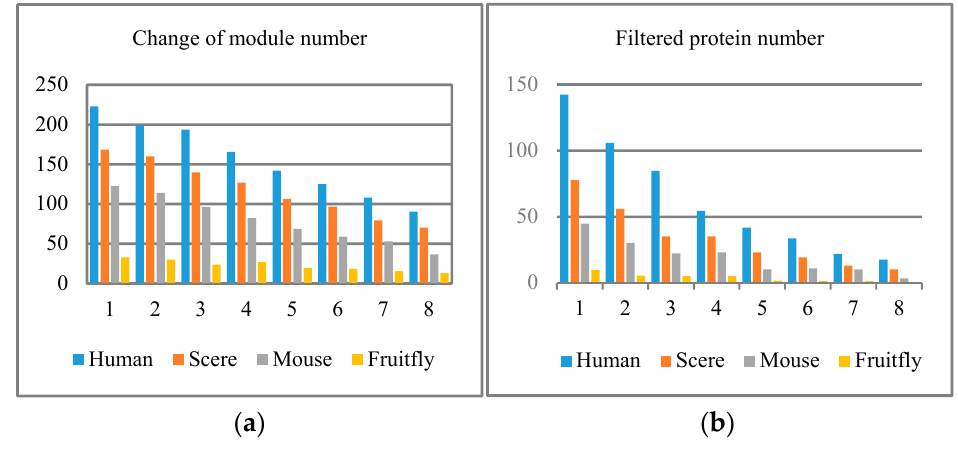
Figure 3. Four species experimental results. Threshold value changes among 1 (0.05), 2 (0.055), 3 (0.06), 4 (0.065), 5 (0.07), 6 (0.075), 7 (0.08), 8 (0.085). ( a ) Change of module number; ( b ) filtered protein number.